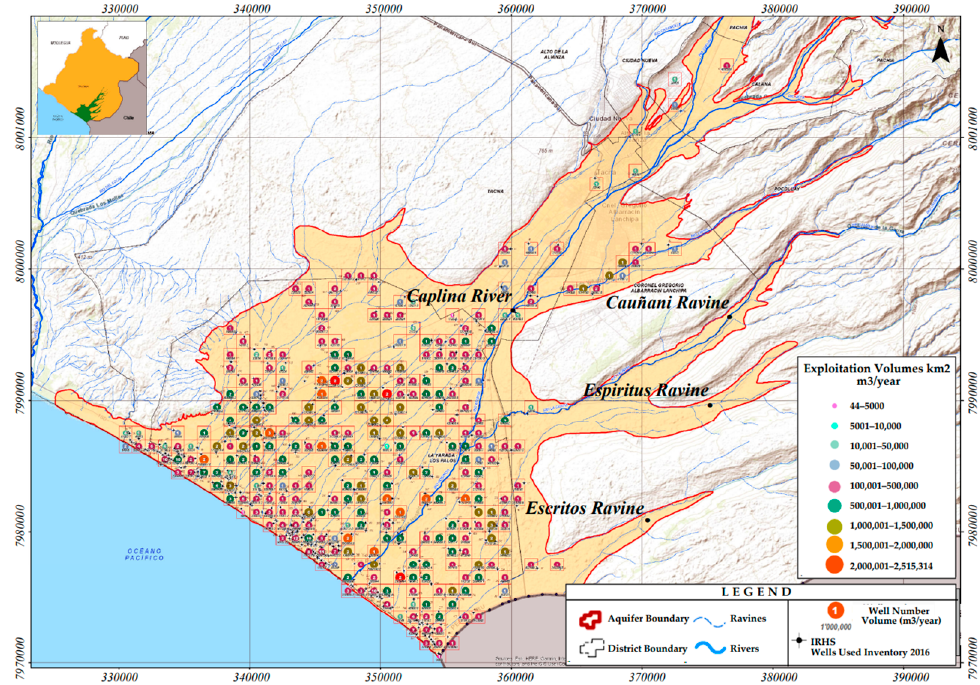
Figure 7. Exploitation volumes map of the Caplina aquifer, 2016. Modified from the Ministry of Agriculture and Irrigation (MIDAGRI).